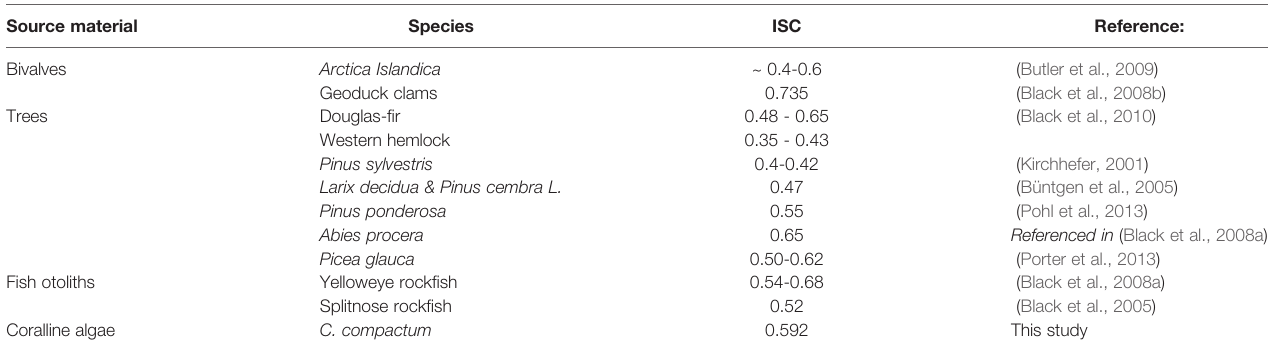
TABLE 3 | Inter-series correlations (ISC) of inter-sample growth replicability compared between other crossdated biogenic proxies. Source